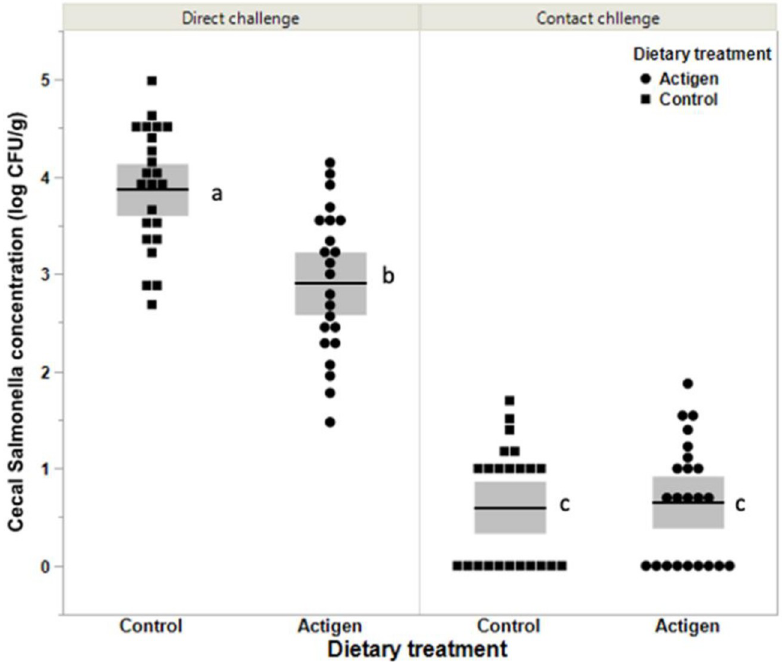
Fig 1. Box plot of the mean concentrations (log 10 CFU/g) of Salmonella in cecal contents from 17 week-old layers 1 week after a direct or contact challenge with S . Enteritidis as influenced by dietary treatment (46/treatment). The boxes represent mean and standard deviation values. Birds were fed either basal diet (Control) or a diet supplemented with 400 g of Actigen 1 /ton from day of hatch through week 17. Direct challenged birds were challenge on week 16 with 1.7 X 10 9 CFU of nalidixic acid resistant S . Enteritidis. Contact challenged birds were exposed to S . Enteritidis by housing them in the same cage as the direct challenged birds. The mean concentrations (log 10 CFU/g) of Salmonella in the ceca of the direct challenged birds were 2.9 ± 0.8 and 3.9 ± 0.6 for the Actigen 1 and Control groups, respectively. The mean concentration of salmonella in the ceca from contact challenged birds were 0.6 ± 0.6 and 0.7 ± 0.6 for the Actigen 1 and control groups, respectively. Means designated by different letters (a, b and c) are significantly different ( P < 0.001).